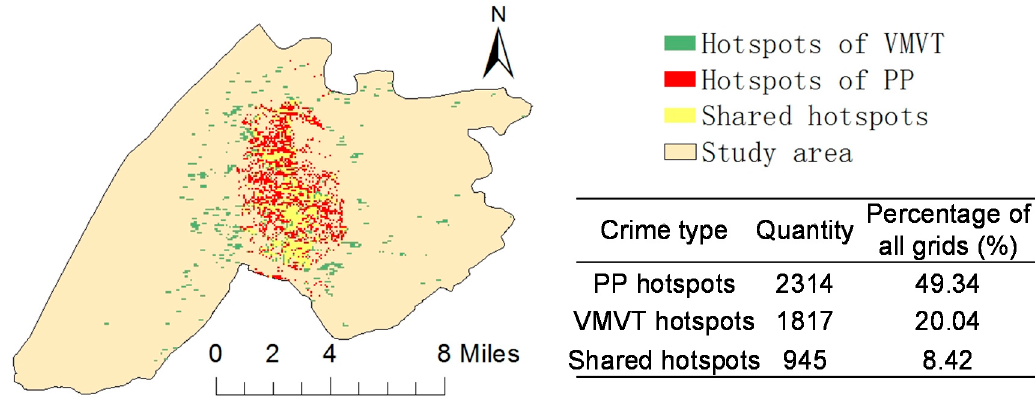
Figure 4. Hotspots of two crime types.